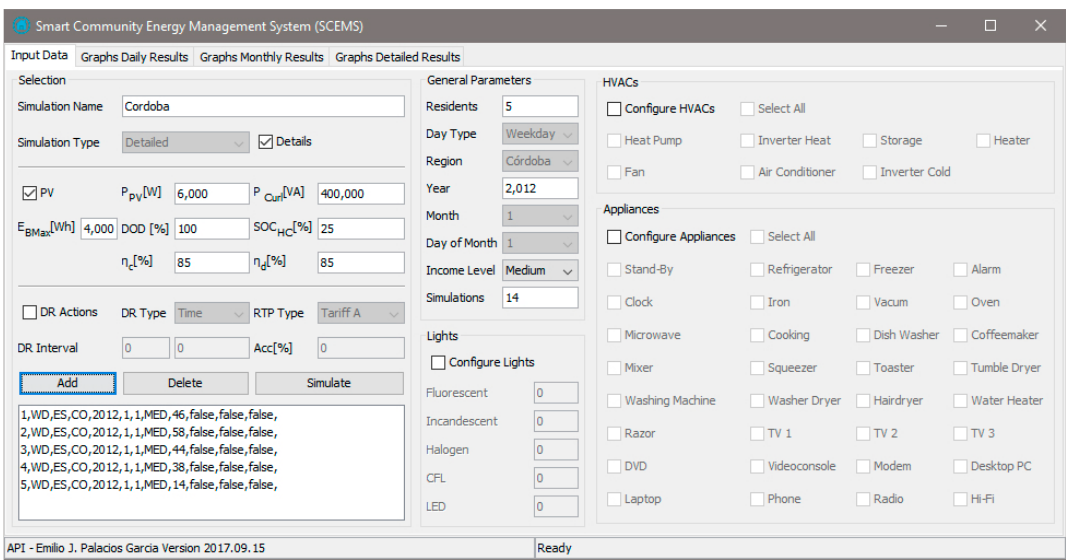
Figure 5. GUI for configuring the simulation parameters of the